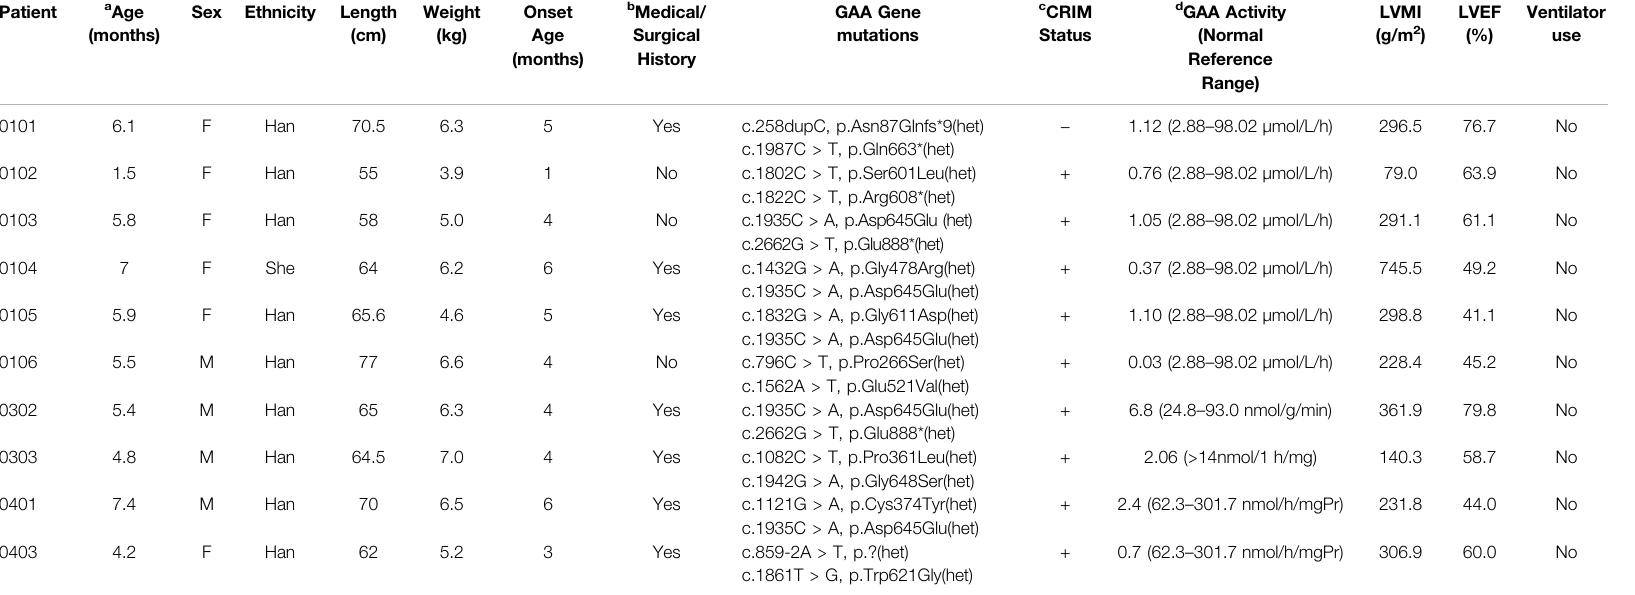
F, female; M, male; w/s, with support. a Age at fi rst infusion. b Other than IOPD. c CRIM status was predicted by GAA gene mutations. d All patients had GAA enzyme test results below the lower limit of the normal reference range. Due to the different GAA enzyme detection methods used in the medical center of each patient, the normal reference value range and numerical unit of each patient in the table are different. LVEF: left ventricular ejection fraction. LVMI: left ventricular mass